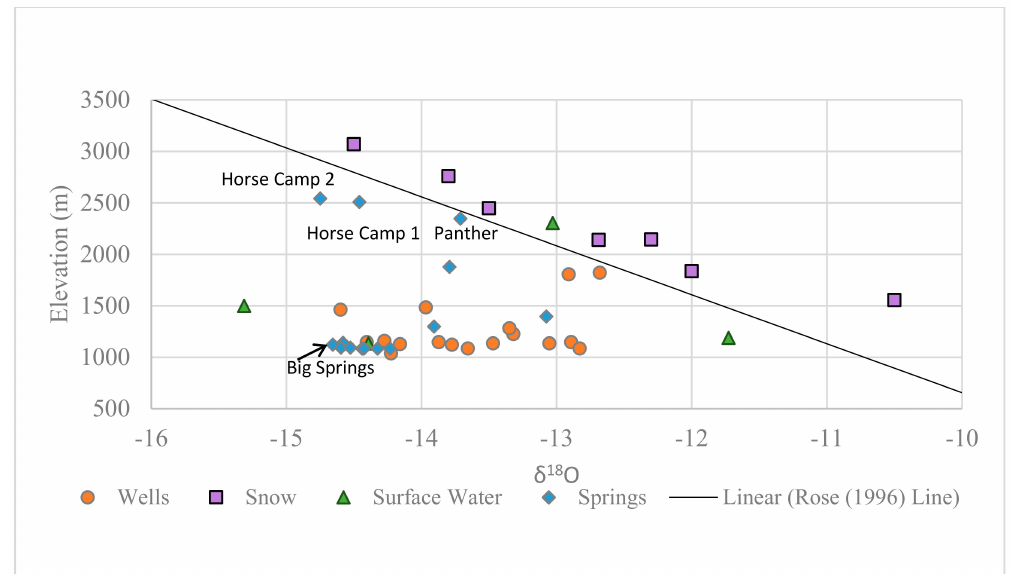
Figure 3. Altitude effect on water isotopic composition: measured δ 18 O of sampled water plotted against sampling elevation for well, spring, surface water and snow samples. The black line indicates a lapse rate of 2.3 ‰ decrease in δ 18 O per 1000 m increase in elevation (Rose et al., 1996)